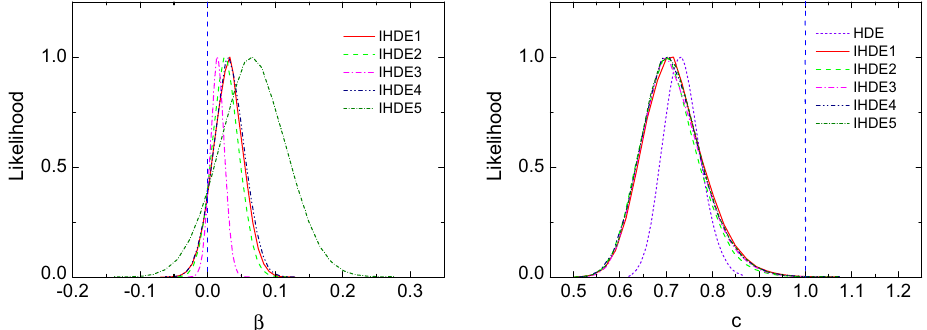
Fig. 5 One-dimensional marginalized posterior distributions of parameters β (left panel) and c (right panel) for the HDE model and the IHDE models, from the SN+CMB+BAO+ H 0 data. The blue dashed lines denote the cases of β = 0 (left panel) and c = 1 (right